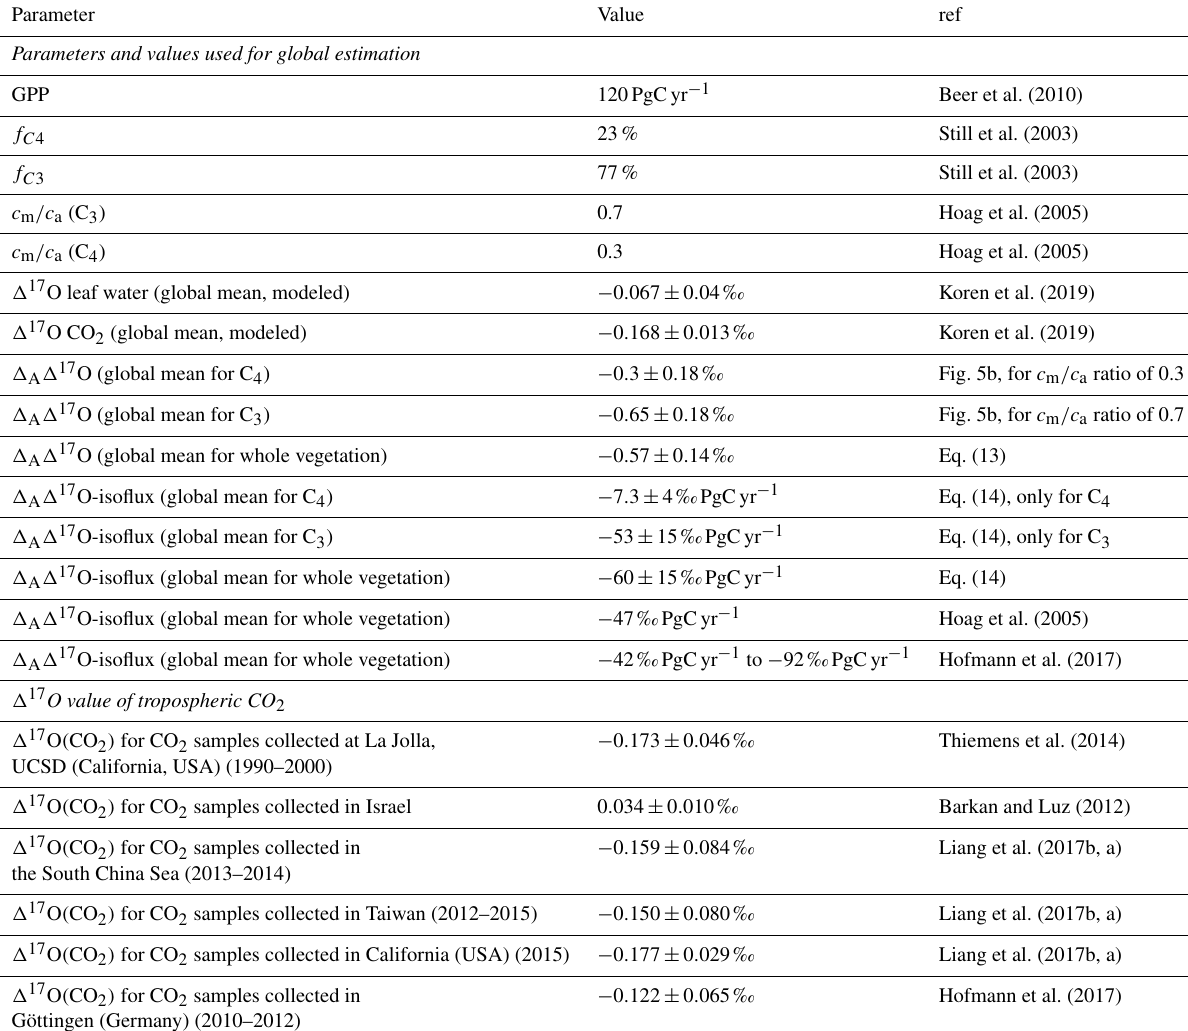
Table 3. Summary of the parameters used for the extrapolation of leaf-scale experiments to the global scale and the results obtained, as well as an overview of available (cid:49) 17 O measurements.